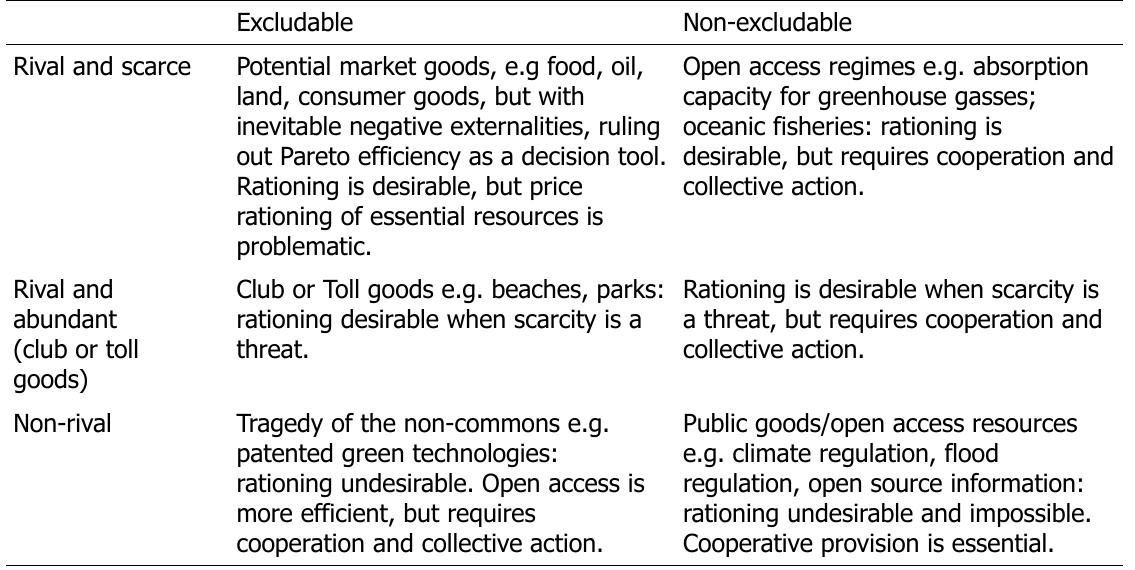
Table 1. Resource Characteristics and their Implications for